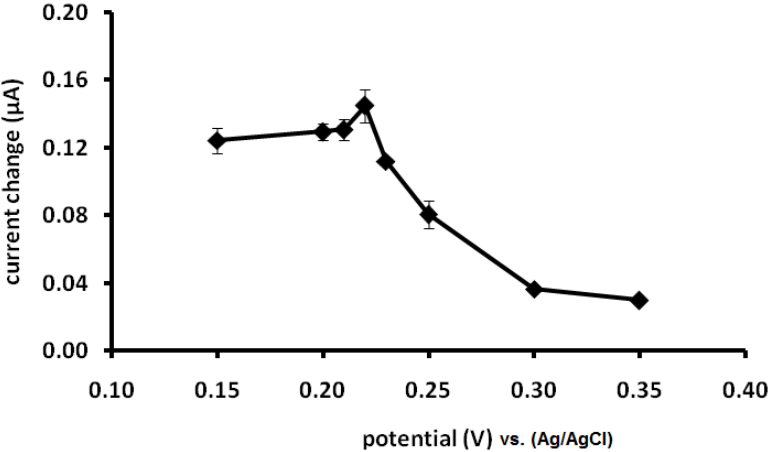
Figure 3. Effect of applied potential on the current response of the biosensor (measurement was performed at 196.1 µM capsaicin in the presence of 50 µM H pH 7/0.1 M NaCl).